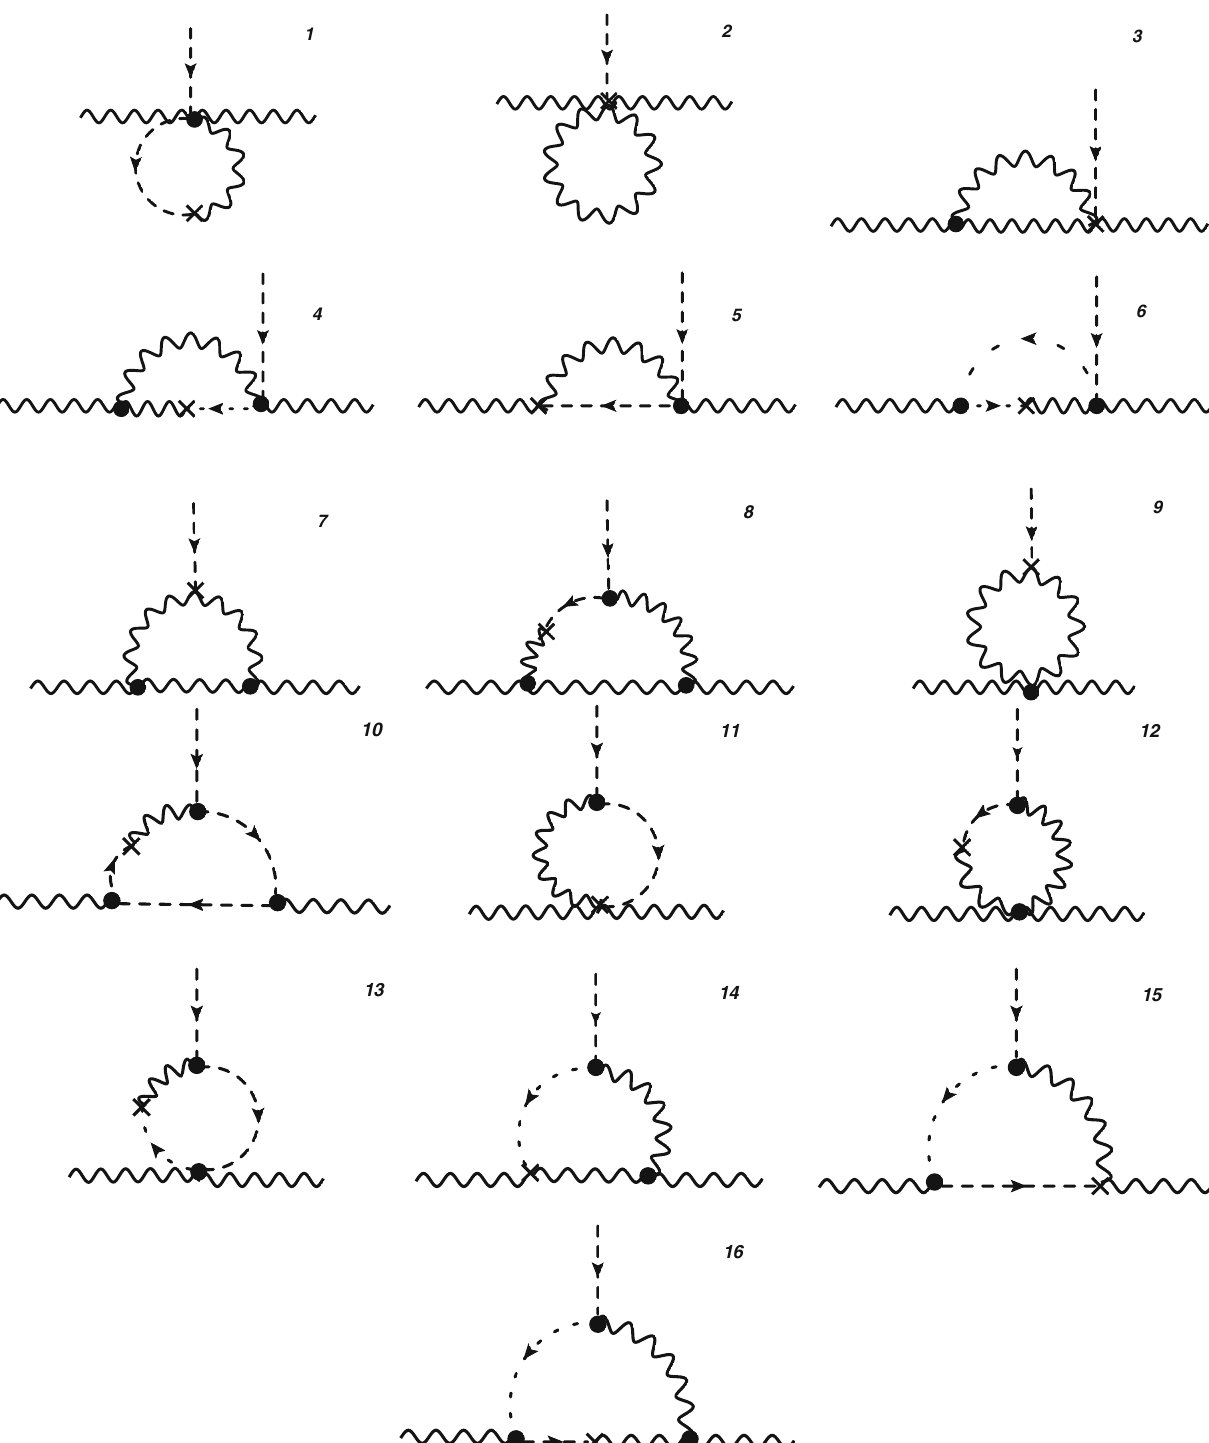
Fig. 2 One-loop Feynman diagrams contributing to the three point Green’s function of the Gluino-Glue operator, (cid:7) u ν u μ O Gg ¯ λ (cid:5) . A wavy (dashed) line represents gluons (gluinos). Diagrams 1, 2, 3, 5, 6, 11, and 13 do not appear in dimensional regularization but they contribute in the